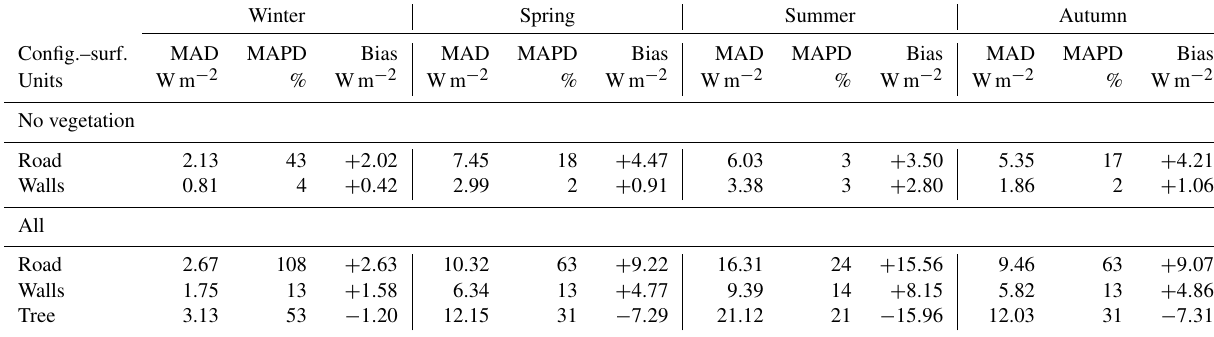
Table 3. Statistical scores for absorbed shortwave radiation flux by surfaces regarding the seasons. Winter Spring Summer Autumn Config.–surf. MAD MAPD Bias MAD MAPD Bias MAD MAPD Bias MAD MAPD Bias Units Wm −